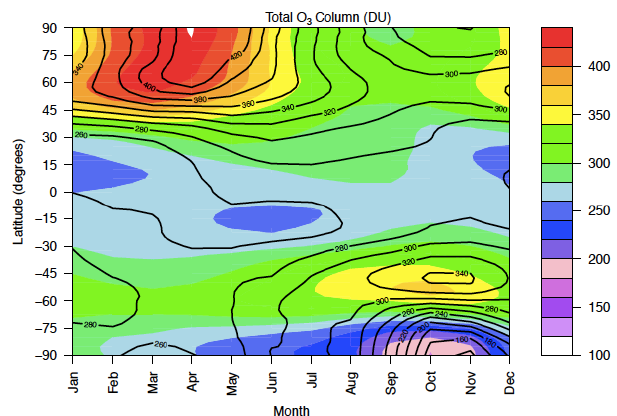
Fig. 8. Comparison between assimilated total ozone column data (Bodeker et al., 2005) (lines) and the stratospheric chemistry model (filled coloured